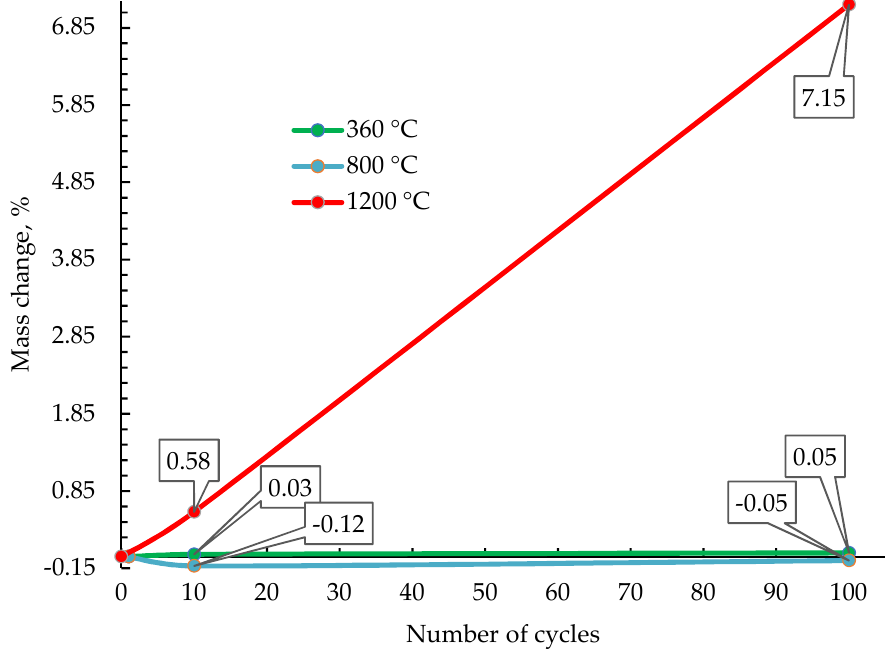
Figure 3. Dependence of the surface roughness parameters of the beryllium samples on the conditions of exposure to hydrogen